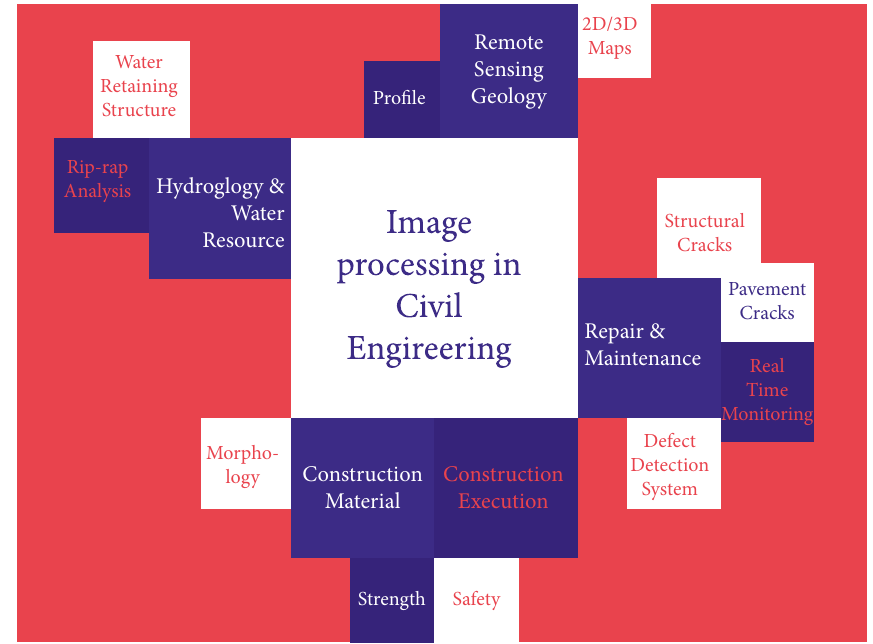
Figure 2: Image processing applications in civil